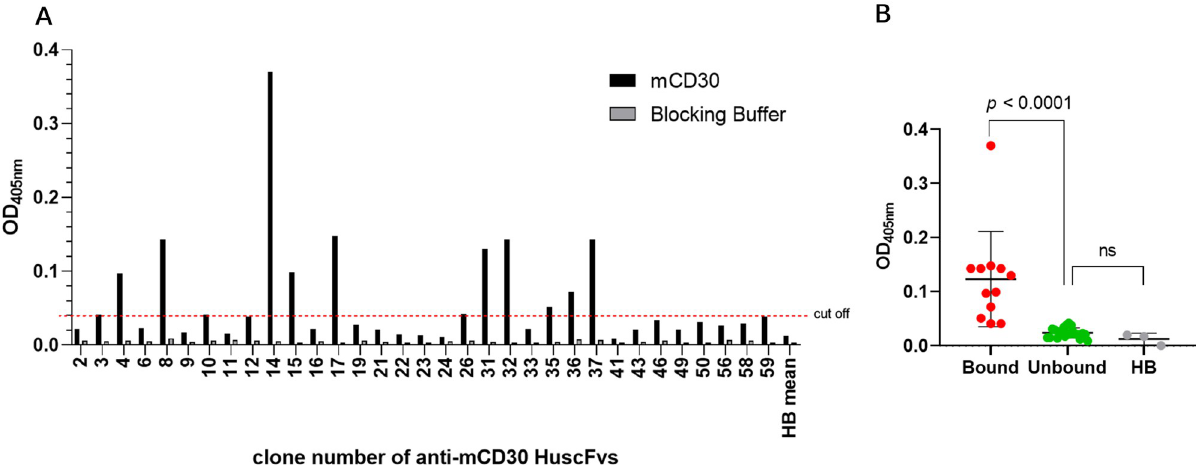
Fig 1. Clonal selection of mCD30-bound ScFvs. (A) The screening of E . coli clones that produced mCD30-bound ScFvs by indirect ELISA used the mCD30 peptide as a peptide-coated plate and the blocking buffer as a non-coated plate (negative control) in the side-by-side wells. Bound ScFvs were selected from the OD 405nm signal above the mean + 3 SD of the background binding control (lysate of original E . coli HB2151; HB) (cut off = 0.03875). Lysates of 12 scFv -positive E . coli clones (#A3, A4, A8, A10, A14, A15, A17, A31, A32, A35, A36, and A37) produced soluble ScFvs bound to the mCD30 peptide. (B) The statistical significance between the bound, unbound ScFvs groups and the HB control was analyzed by one-way ANOVA and Tukey’s post hoc test.